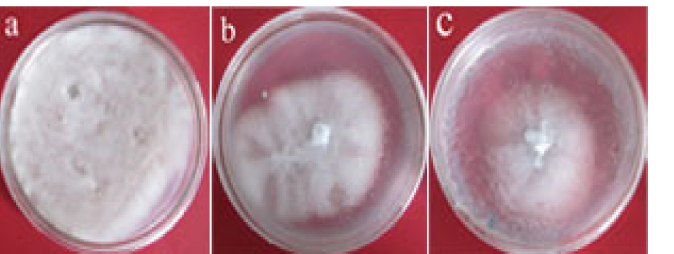
Figure 7. Growth and propagation of V. dahliae in the media with different tobacco protein extracts: ( a ) water control; ( b ) non-transgenic line; ( c ) transgenic line